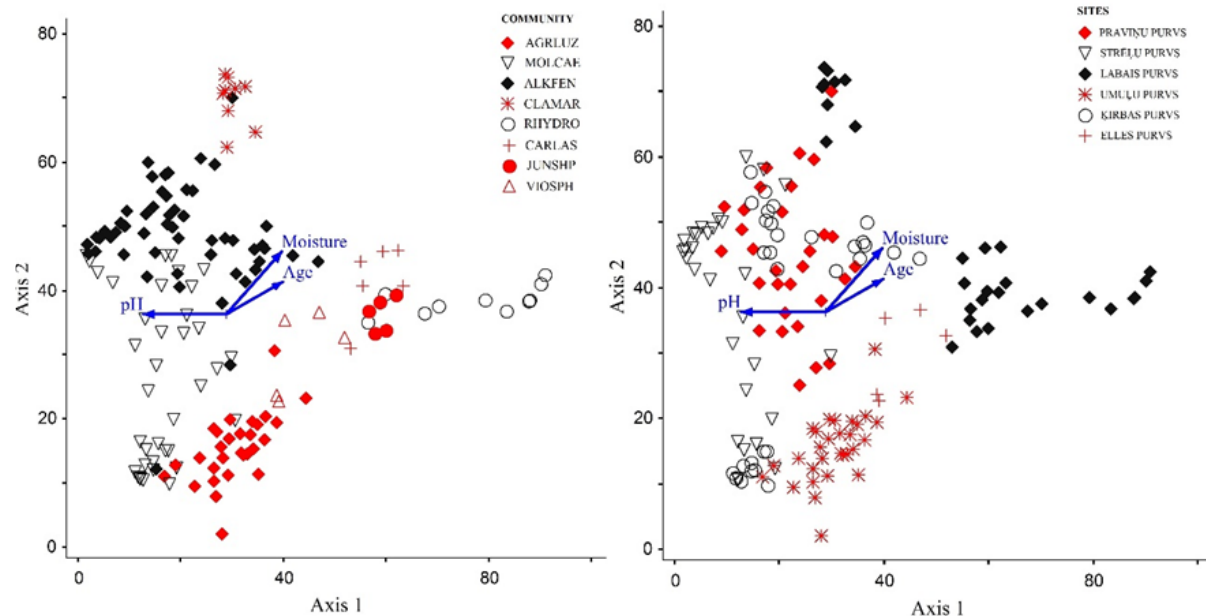
Figure 3. DCA ordination of vegetation plots, grouped according to their affiliations to plant communities (TWINSPAN division, see Table 2).